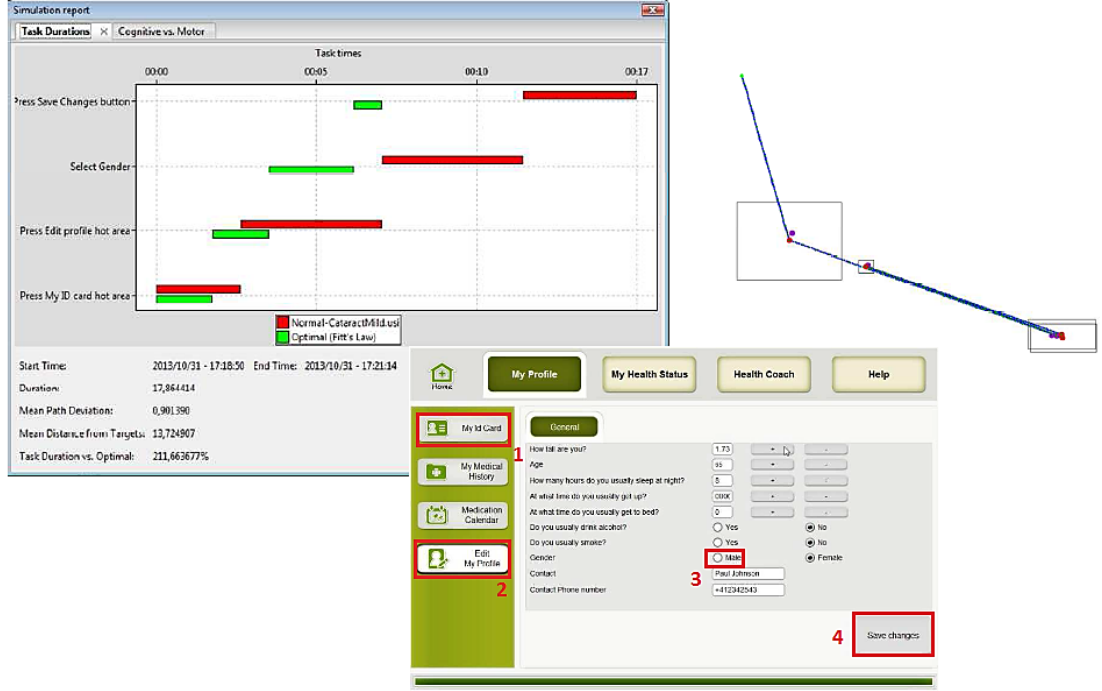
Figure 14. User 2 Cognitive VUM simulation: Edit health profile.